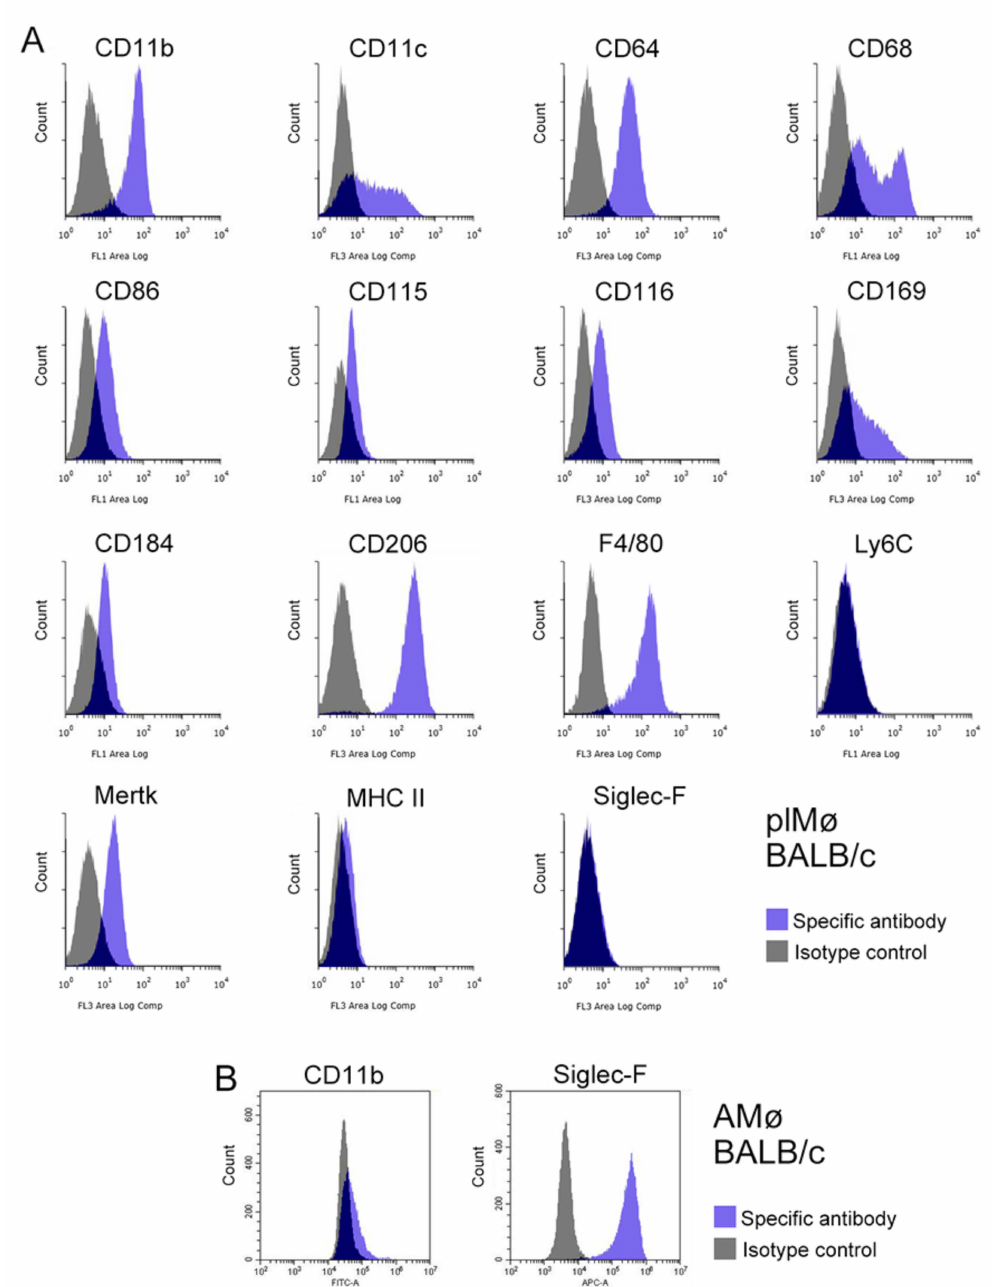
Figure 4. Representative histograms from flow cytometric analyses, showing the expression of 15 Mø/monocyte markers in propagated lung tissue-resident Mø by co-culturing as well as the CD11b and Siglec-F expression in alveolar Mø from BALB/c mice. ( A ): The expression patterns of CD11b, CD11c, CD64, CD68, CD86, CD115, CD116, CD169, CD184, CD206, F4/80, Ly6C, Mertk, MHC II and Siglec-F in propagated lung tissue-resident Mø (plMø) by co-culture and subculture (blue histogram, specific antibody; grey histogram, isotype control). Cell suspensions were pre-treated with an anti-mouse CD16/32 antibody and then treated with a fluorochrome-labelled test antibody or the same amount of fluorochrome-labelled isotype control antibody. plMø shows the characteristic expression patterns of Mø/monocyte marker membrane proteins, such as the high expressions of CD11b, CD64 and CD206; substantial/clear expressions of Mertk, CD115 and CD116; as well as no/almost no expressions of Ly6C, MHC II and Siglec-F. Low/faint and high expression fractions can be noted in CD11c, CD68 and CD169. ( B ): CD11b and Siglec-F expression in alveolar Mø (AMø) from BALB/c